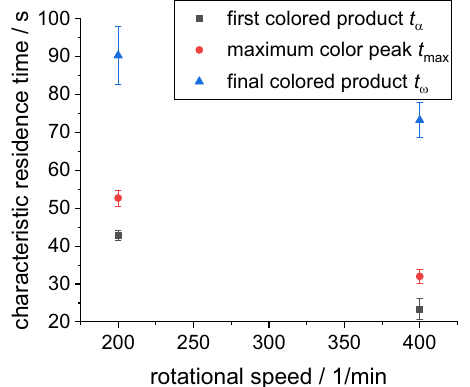
Figure 6: In fl uence of rotational speed on the characteristic resi - dence times of the extrudate for p -